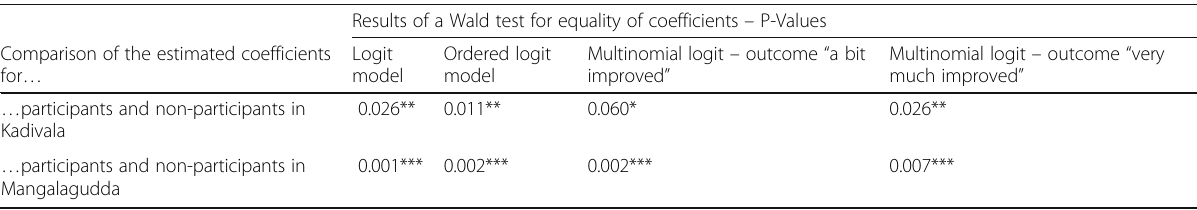
Table 3 Wald tests for equality of coefficients for non-participants and participants in the model villages Comparison of the estimated coefficients for …